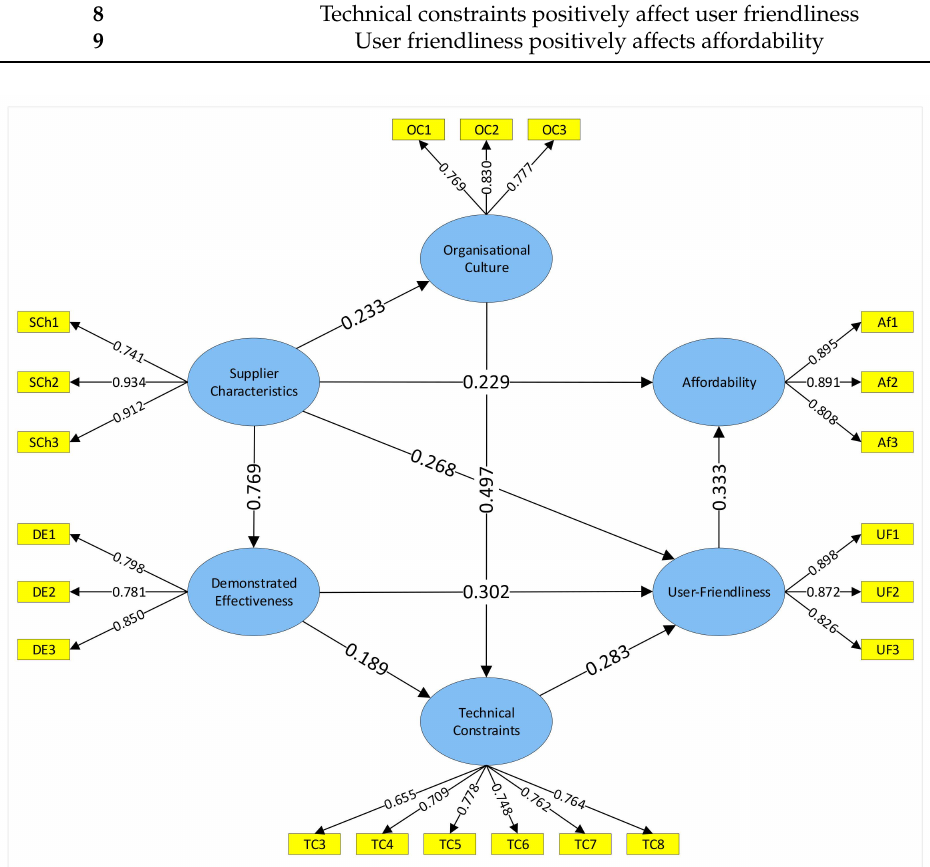
Figure 3. PLS model with factor loadings and path